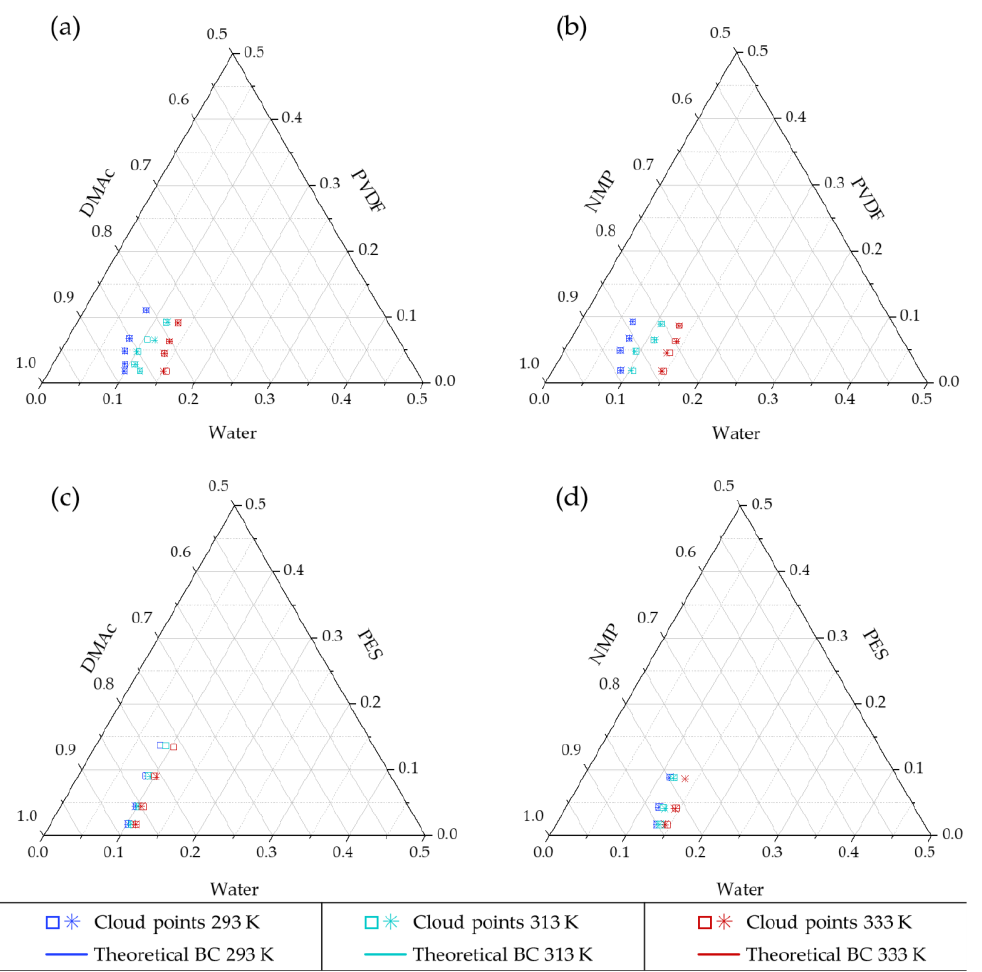
Figure 3. Cloud points at 293, 313 and 333 K of ( a ) PVDF – DMAc – water, ( b ) PVDF – NMP – water, ( c ) PES – DMAc – water and ( d ) PES – NMP – water systems. Duplicated experimental results are represented by □ and *. Significant statistical difference with Student’s t -test ( p < 0.05) was found in all systems comparing points between 293 and 313 K and between 313 and 333 K. Significant difference was also found at 293 K between systems comparing the use of DMAc and NMP with the same polymer and between PVDF and PES with the same